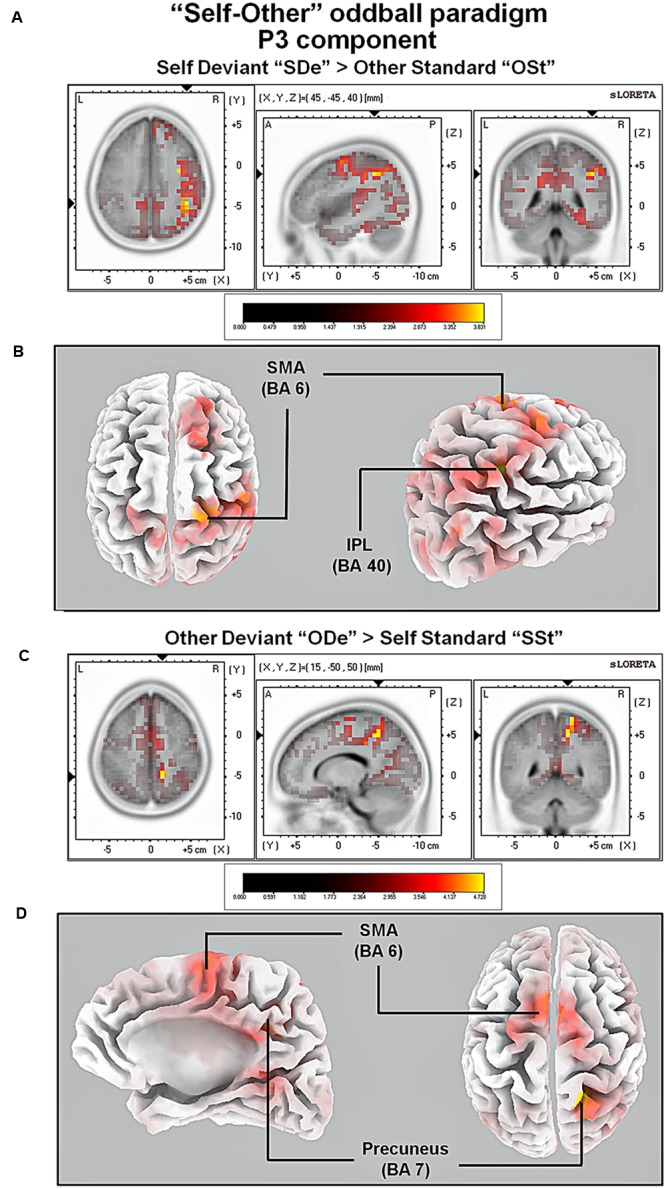
Results of the sLORETA source localization analysis (contrasts: “SDe” > “OSt” and “ODe” > “SSt,” respectively) in the averaged time window of the P3 components (295–367 and 275–387 ms, respectively). Images have been obtained after SnPM and co-registration to the stereotaxic Talairach space based on the Co-Planar Stereotaxic Atlas of the Human Brain (Talairach and Tournoux, 1988) and the probabilistic MNI-152 template (Mazziotta et al., 2001). Activated voxels are indicated by yellowish and reddish colors [after correction for multiple comparisons (p < 0.01 and p < 0.05, respectively)]. (A) The peak of highest cortical activity was found in the right inferior parietal lobule (IPL; BA 40). (B) A lateral view on the right hemisphere (right panel) and a top view on the whole brain (left panel) show highest cortical activations in the right IPL (BA 40) and the left supplementary area (SMA; BA 6) rendered on the Colin27 template (Holmes et al., 1998). (C) The peak of highest cortical activity was found in parts of the right precuneus (BA 7). (D) A top view on the whole brain (right panel) and additionally a medial view on right hemisphere (left panel) show cortical activations in the right precuneus (BA 7) and bilaterally in the supplementary motor area (SMA; BA 6) on the rendered Colin27 template (Holmes et al., 1998). L, left; R, right; A, anterior; P, posterior; MNI, Montreal Neurological Institute; X, Y, Z, corresponding MNI coordinates; BA, Brodmann area; TPJ, temporoparietal junction.